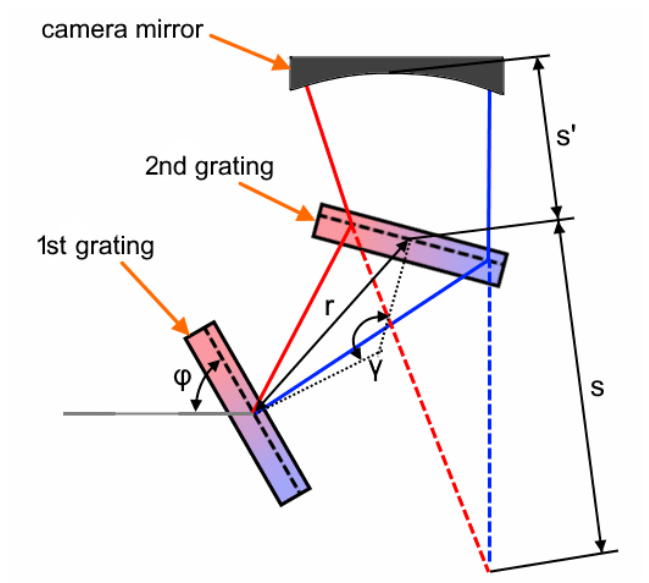
Figure 1. Chief ray tracing through a double dispersive unit. The s + s’ distance corresponds to the equivalent pupil